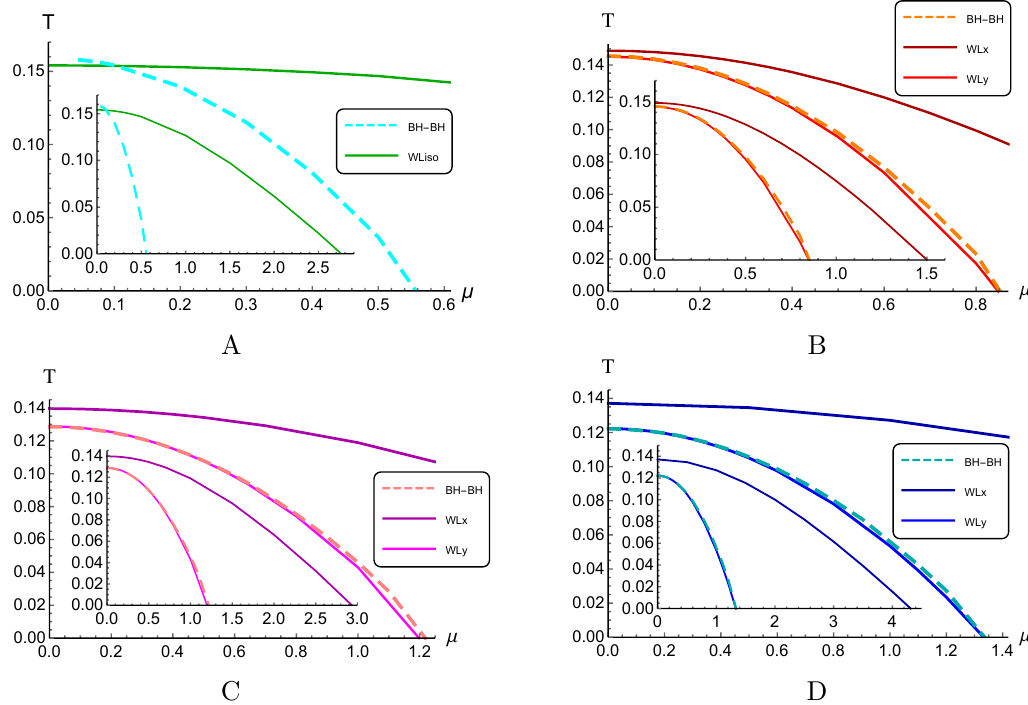
Figure 20 . Confinement/deconfinement phase diagram T ( µ ) in isotropic (A) and anisotropic cases for ν = 1 . 5 (B), ν = 3 (C), ν = 4 . 5 (D); a = 4 . 046 , b = 0 . 01613 , c = 0 . 227 . Dashed lines show Hawking-Page-like phase transitions (BH-BH).